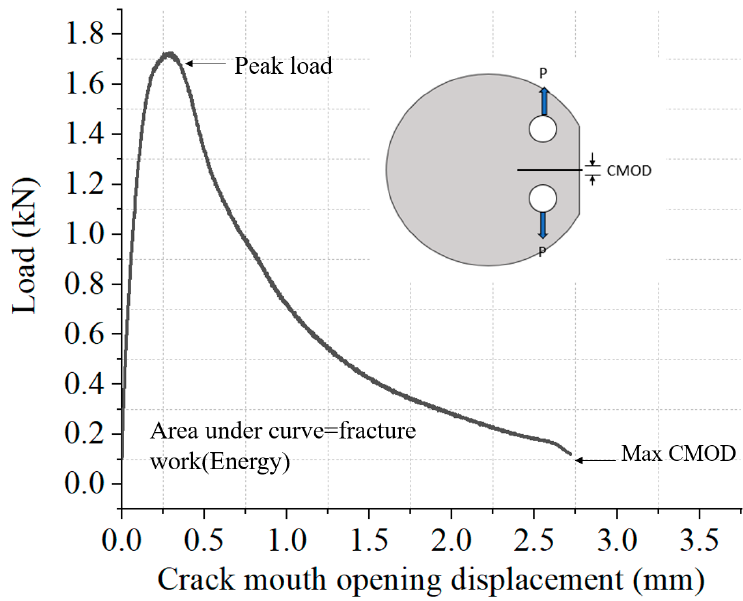
Figure 3. Demonstration of the DCT test procedure.